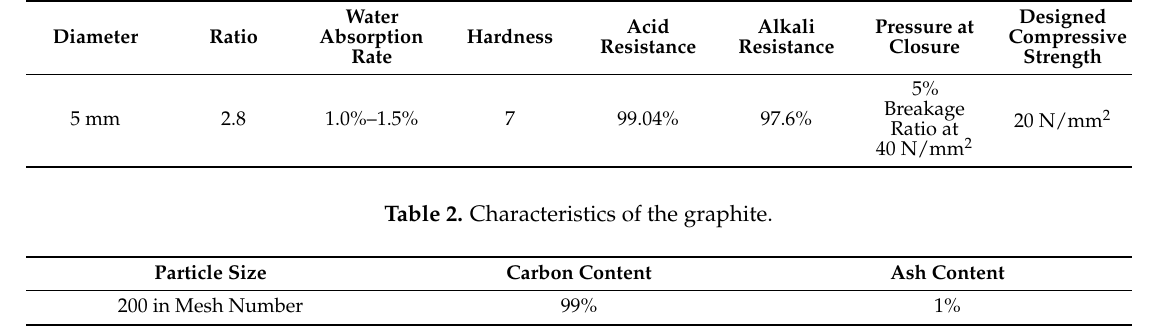
Table 1. Characteristics of the marbles.